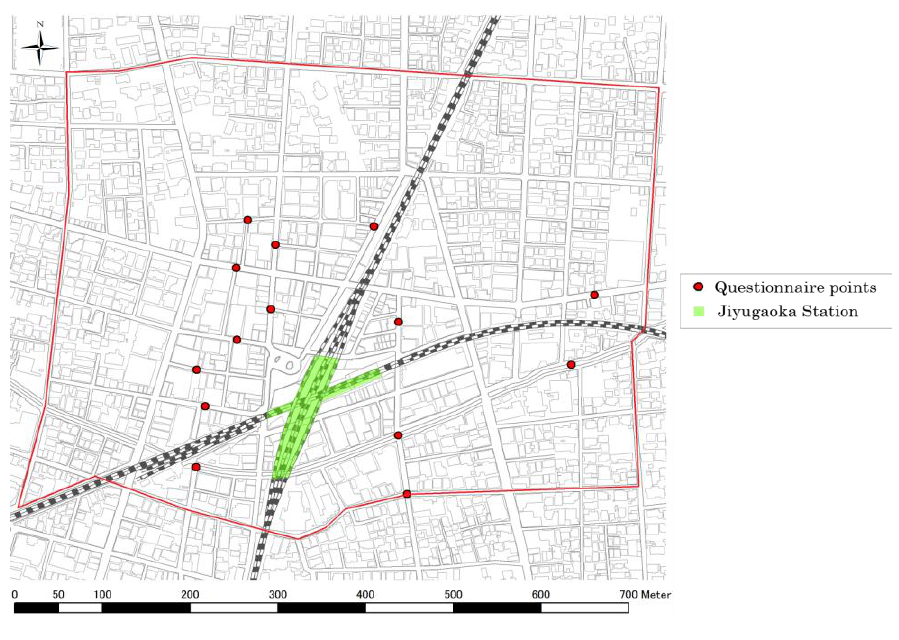
Figure 1. Study area and questionnaire survey points.